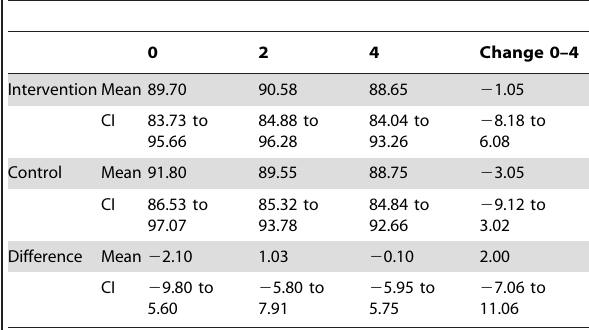
Table 6. Development of Diastolic Blood Pressure during the